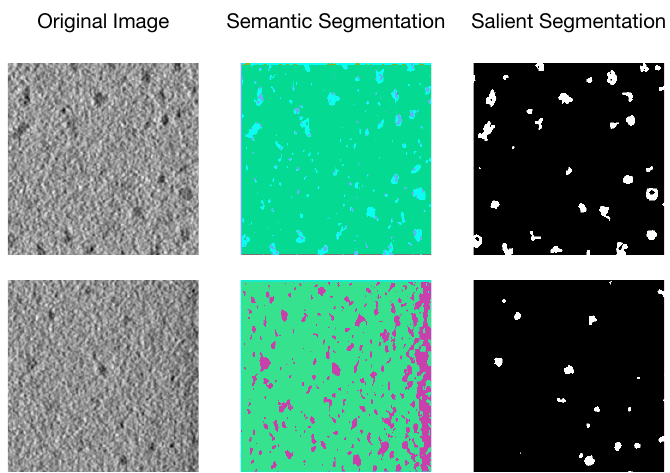
Figure 1. An unsupervised example of semantic segmentation and salient segmentation on CECT